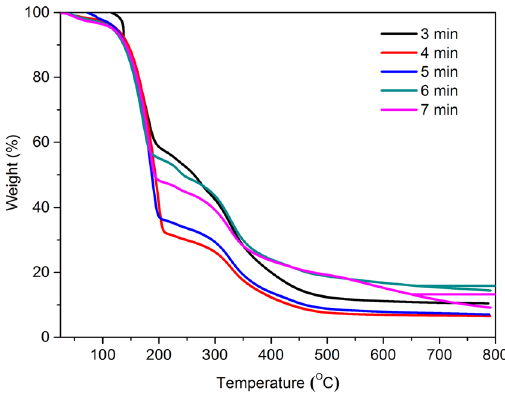
Figure 11: TG curves of BSA/AM microcapsules at di ff erent ultra - sound times.